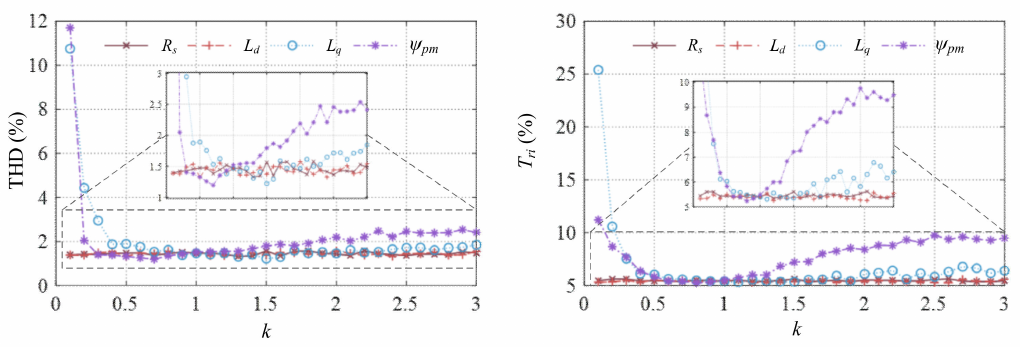
Figure 15. Performance of DSVM-MPC when parameters were set k times the actual value.